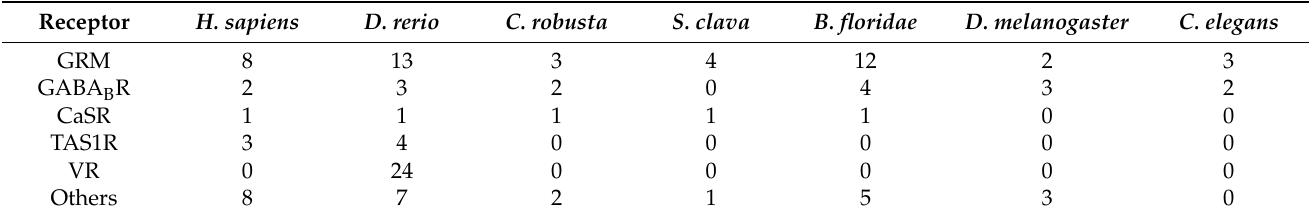
Table 3. The numbers of class C GPCRs in S. clava and other species. The data were collected from GPCRdb, Ensemble (https://www.ensembl.org/index.html, accessed on 15 March 2022), and